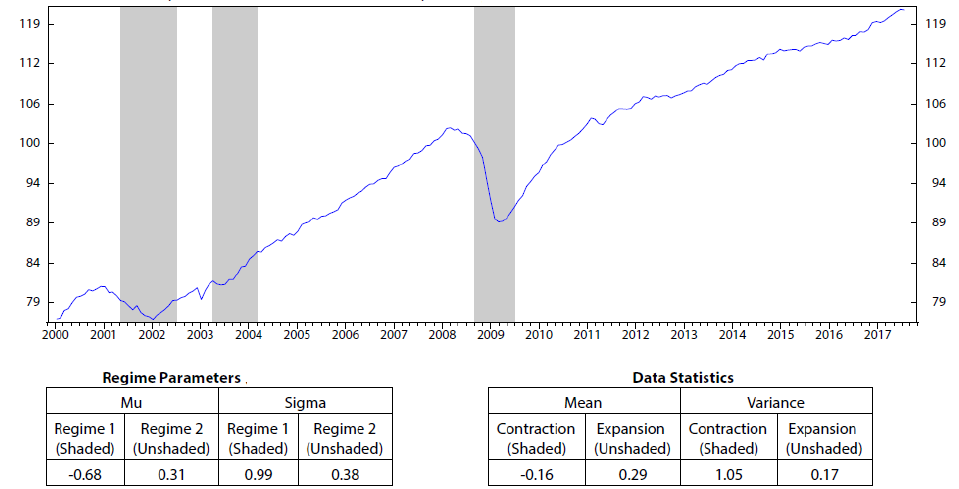
Figure A2. The world production and its regimes detected using HMM for monthly data from 31 December 1999 to 31 August 2017. Regime 1 and regime 2 represent contraction and expansion periods,